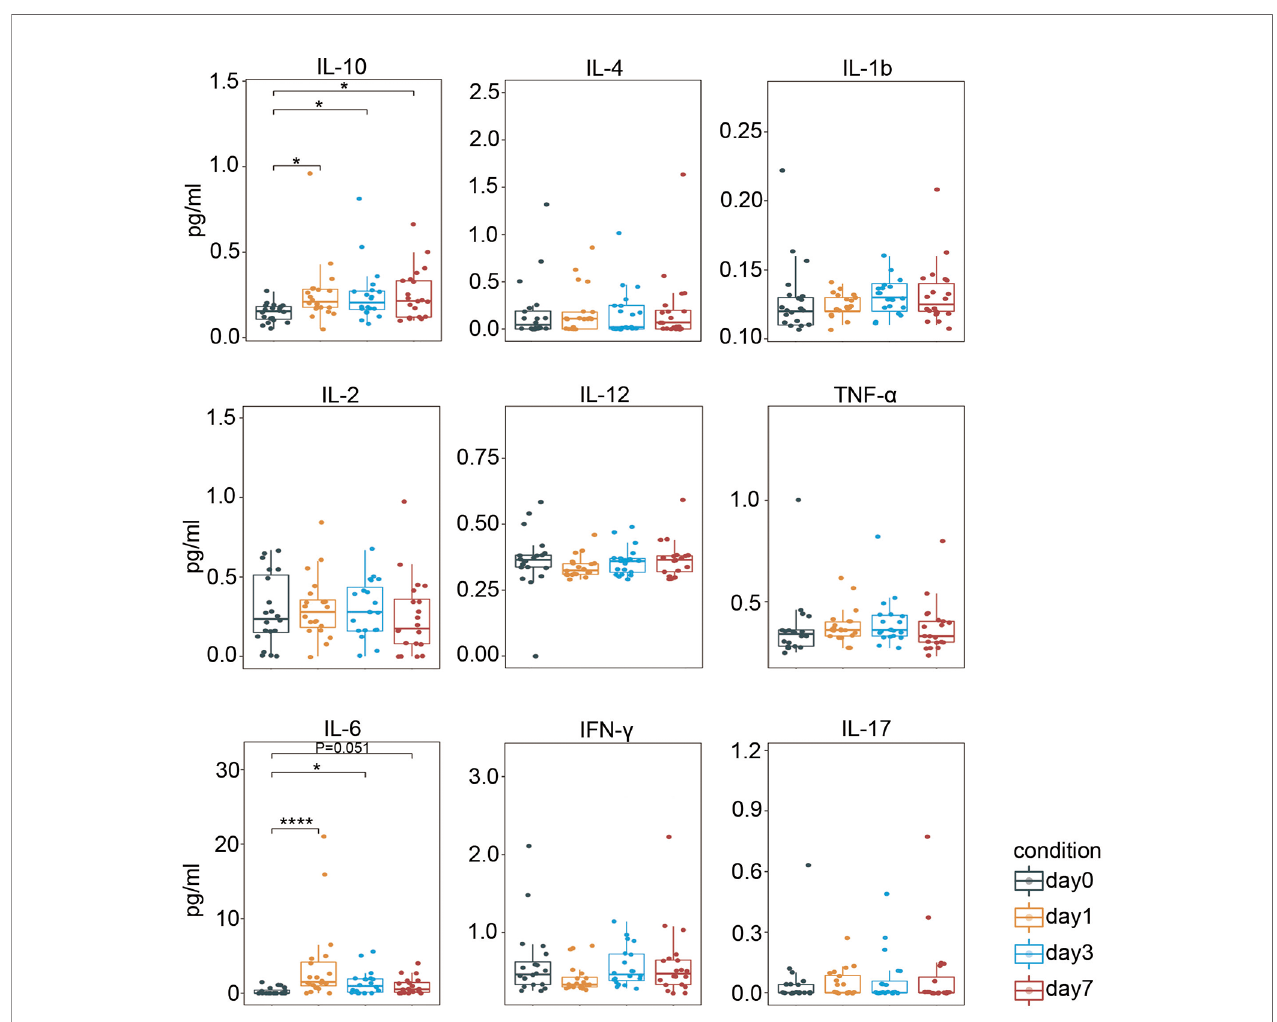
FIGURE 6 | Perioperative serum cytokine levels. Boxplots showing the perioperative serum cytokine secretion measured by ProcartaPlex ™ . IL, interleukin; IFN- g , interferon- g ; TNF- a , tumor necrosis factor- a . *p < 0.05, ****p < 0.0001 by Krustal-Wallis analysis with post-hoc Dunn test. P-value adjusted with the Benjamini- Hochberg